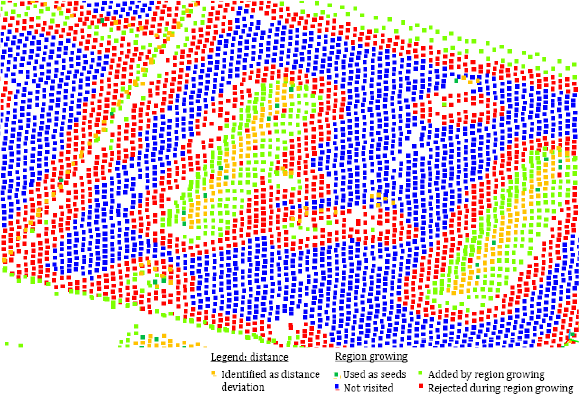
Figure 5. Illustration of the seed selection and region growing algorithm on a building with half-cylindrical roof windows that were absent in the 3D model. Settings used: distance threshold 20 cm and angular threshold 5.73 ◦